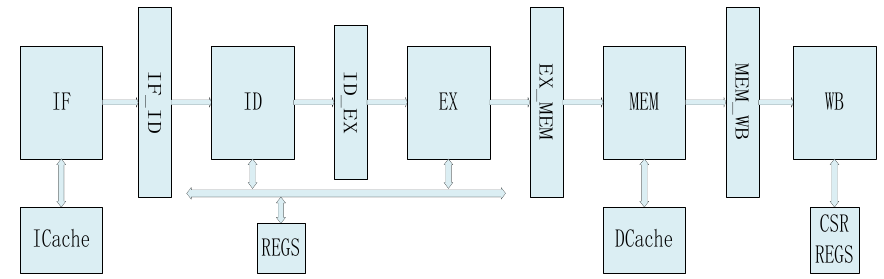
Figure 2. Simple model of the processor core